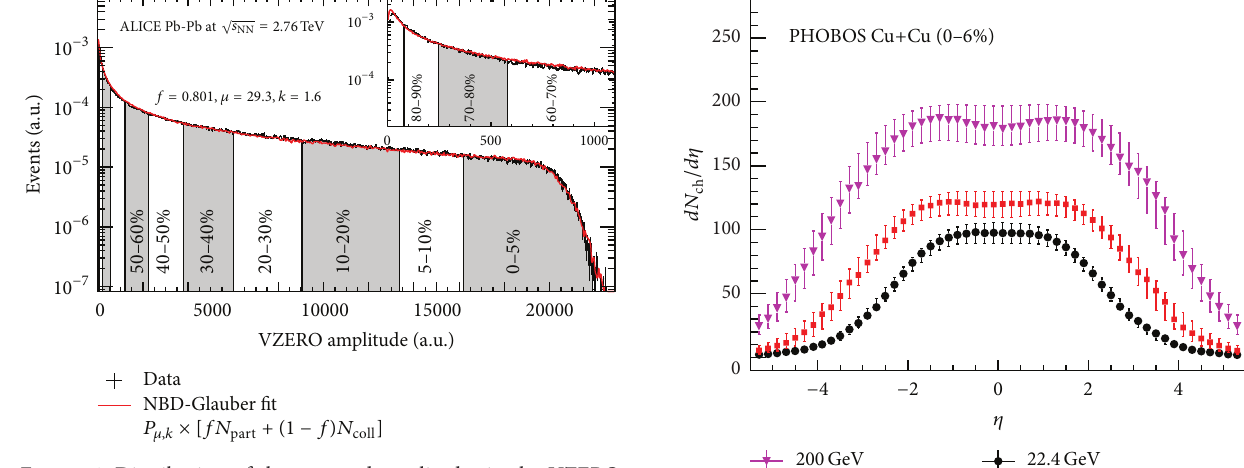
Equation (3) represents the probability of measuring 𝑛 hits per ancestor. Here, 𝜇 represents the mean multiplicity per ancestor and 𝑘 controls the width of the distribution. In 𝑝 + 𝑝(𝑝)